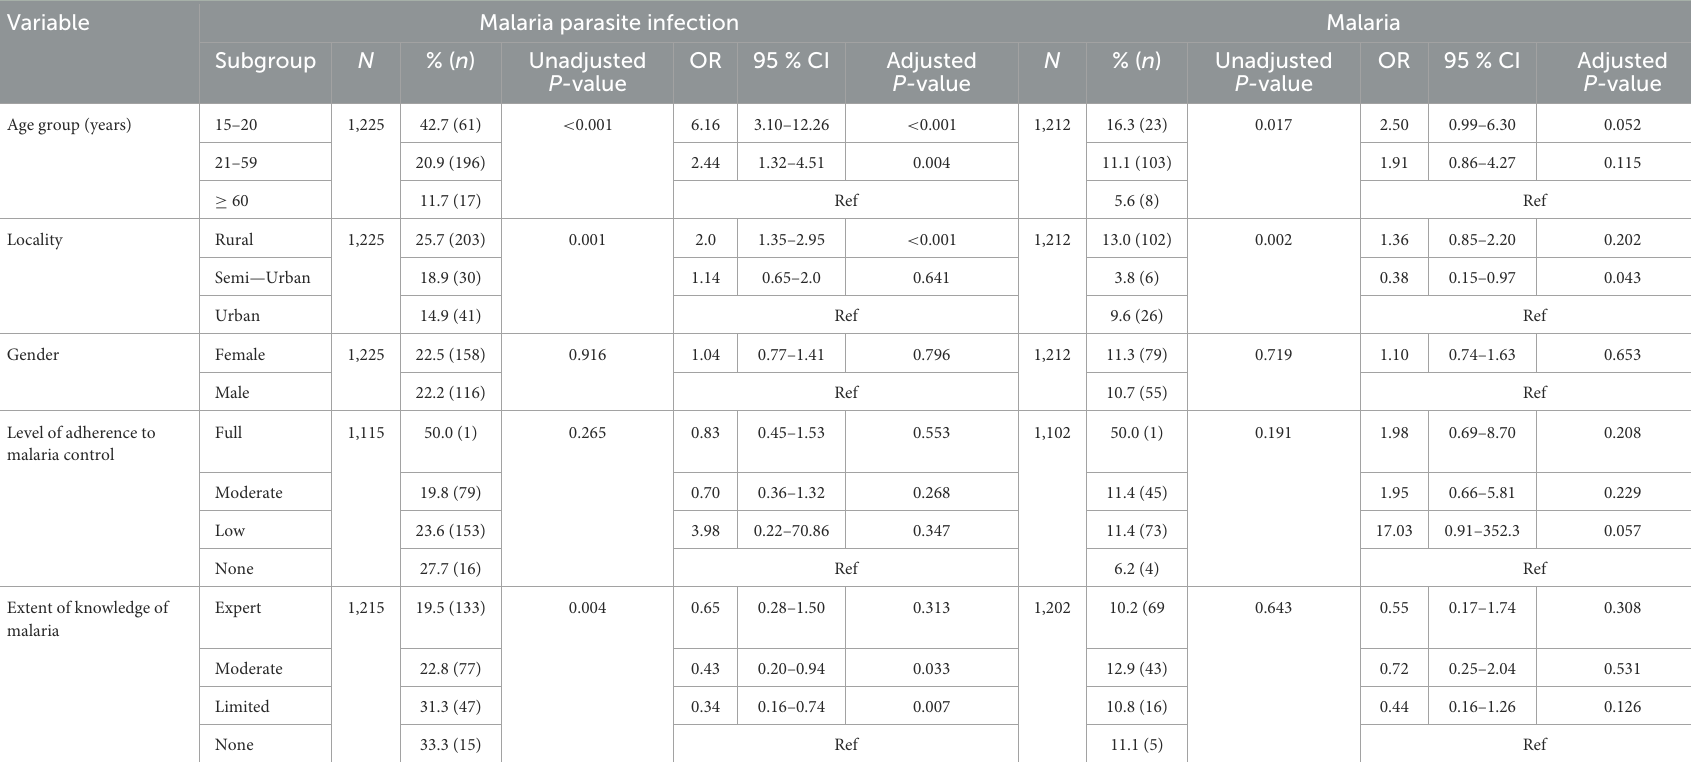
TABLE 6B Relationship between socio-demographic factors, adherence to malaria control, knowledge of malaria and malaria parasitaemia in individuals enrolled through community surveys in Cameroon.